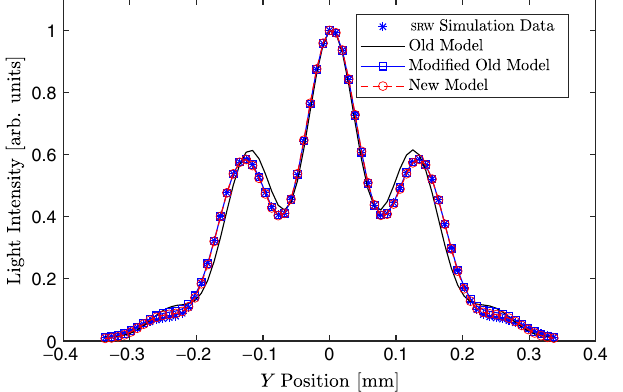
FIG. 5. Comparison of fitting simulated fringe data with three models: the old model (black line), the modified old model (blue rectangle line), and the new model (the red circle dash line). It shows that the modified old model and the new model provide reasonable fittings while the old model fails. The SRW simulation data are the simulated vertical intensity distribution of measure- ment using a D ¼ 5 mm and d ¼ 2 mm double-slit plate for a 1000 MeV beam with 32 . 1 μ m vertical beam size.